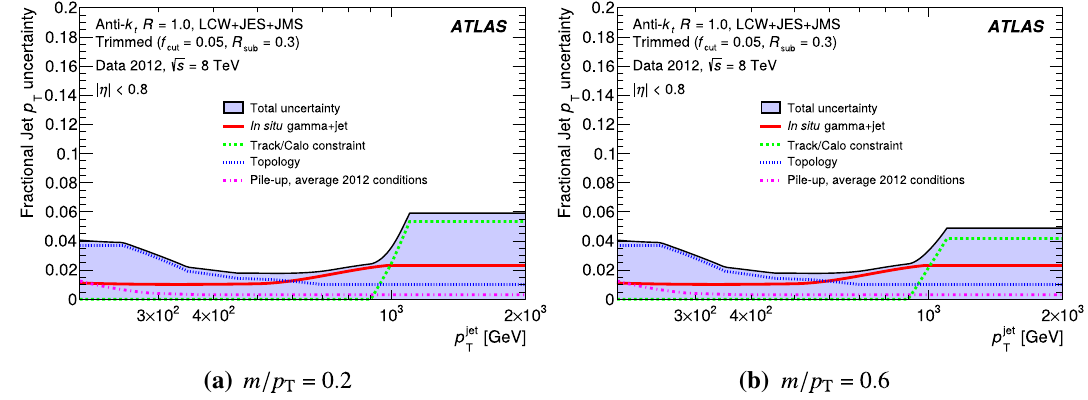
Fig. 48 Combination of the uncertainties in the jet p T scale for anti- k t R = 1 . 0 trimmed jets for | η | = 0 and two values of m / p T : a m / p T = 0 . 20 and b m / p T = 0 .